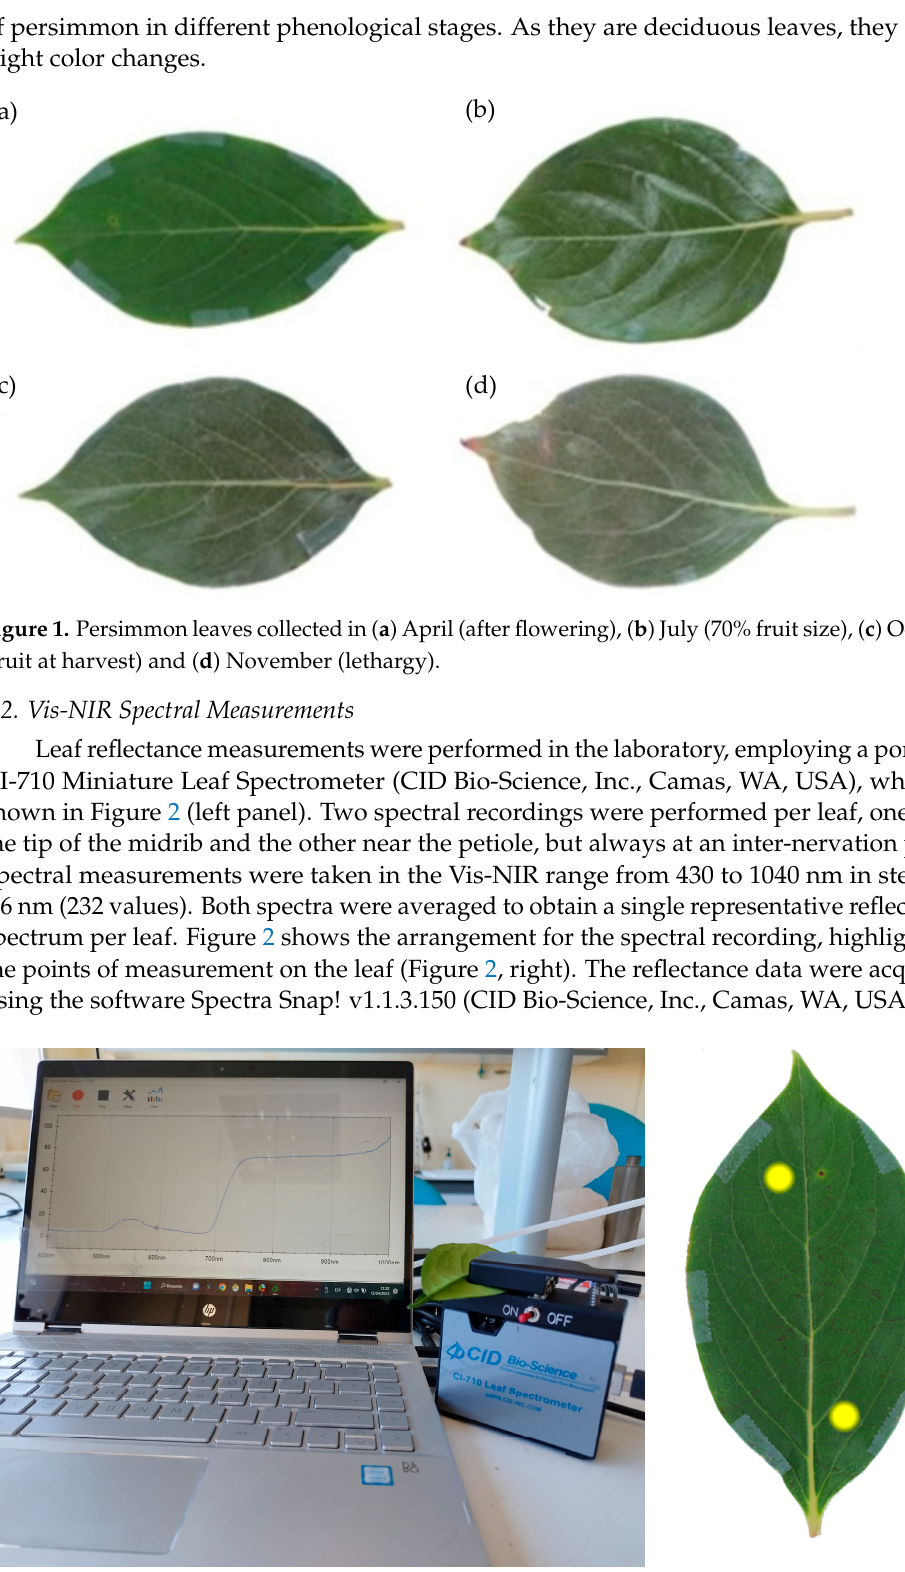
Figure 2. ( Left ): Vis-NIR spectral measurements on persimmon leaves, reflectance mode. ( Right ): measurement points.